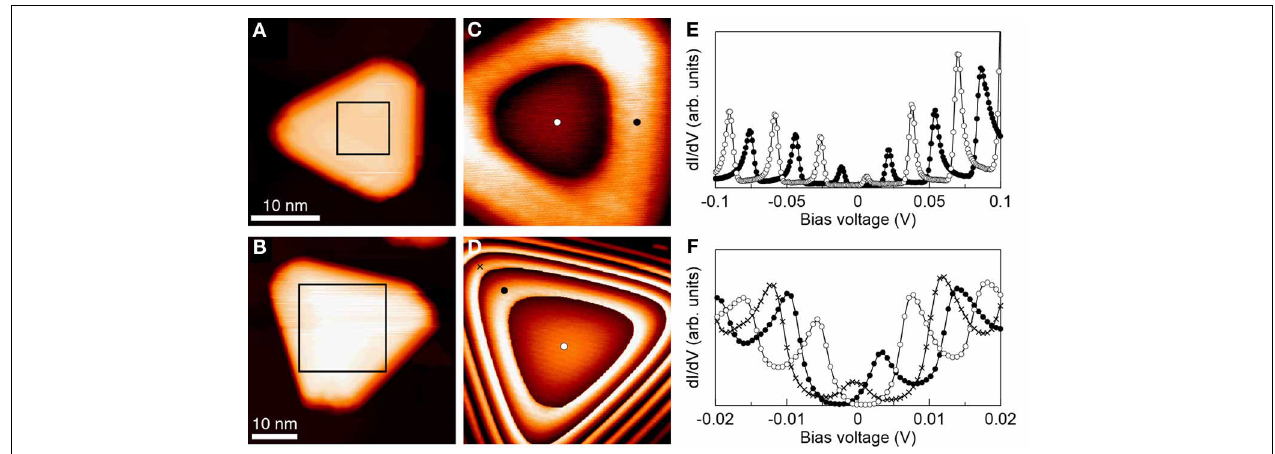
FIGURE 7 | (A,B) Topographic images of Pb islands on NaCl; (A) : − 1V, 20pA, (B) : 2 . 5V, 20pA; (C,D) Close-up view; (C) : − 0 . 15V, 200pA; (D) : − 0 . 01V, 20pA); (E,F) dI / dV spectra acquired on the locations represented by the corresponding symbol, showing different values of Q 0 (see